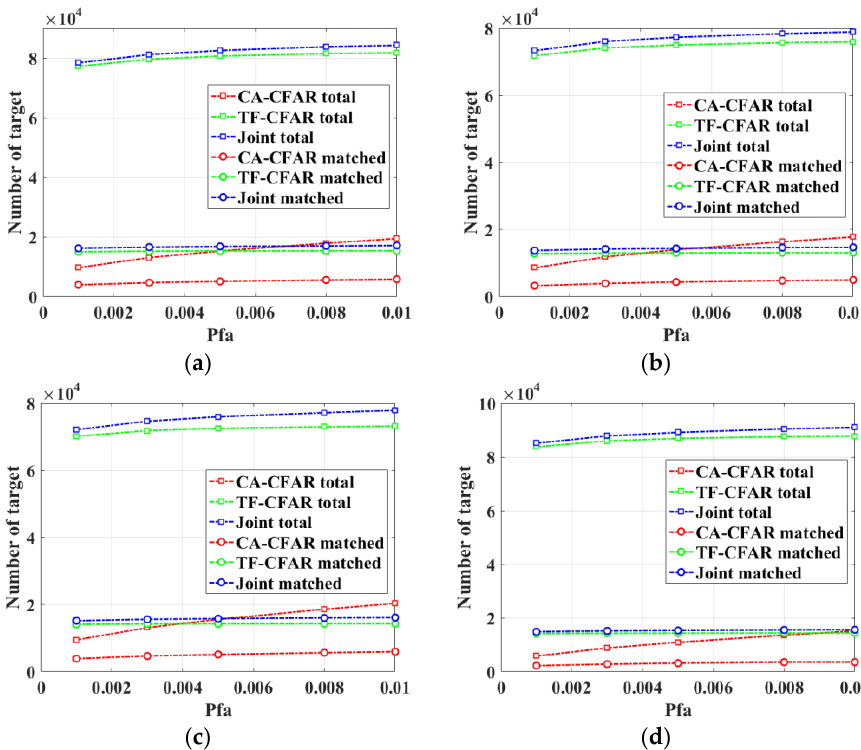
Figure 15. Number of detected targets by the CA-CFAR, TF-CFAR, and the joint method under different P fa on ( a ) 24 September, ( b ) 25 September, ( c ) 26 September, and ( d ) 27 September.